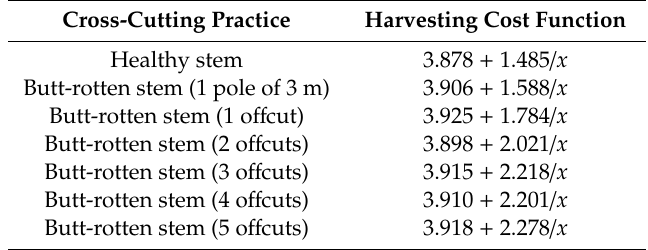
Table 3. Cost functions of timber harvesting for calculating the value recoveries of the